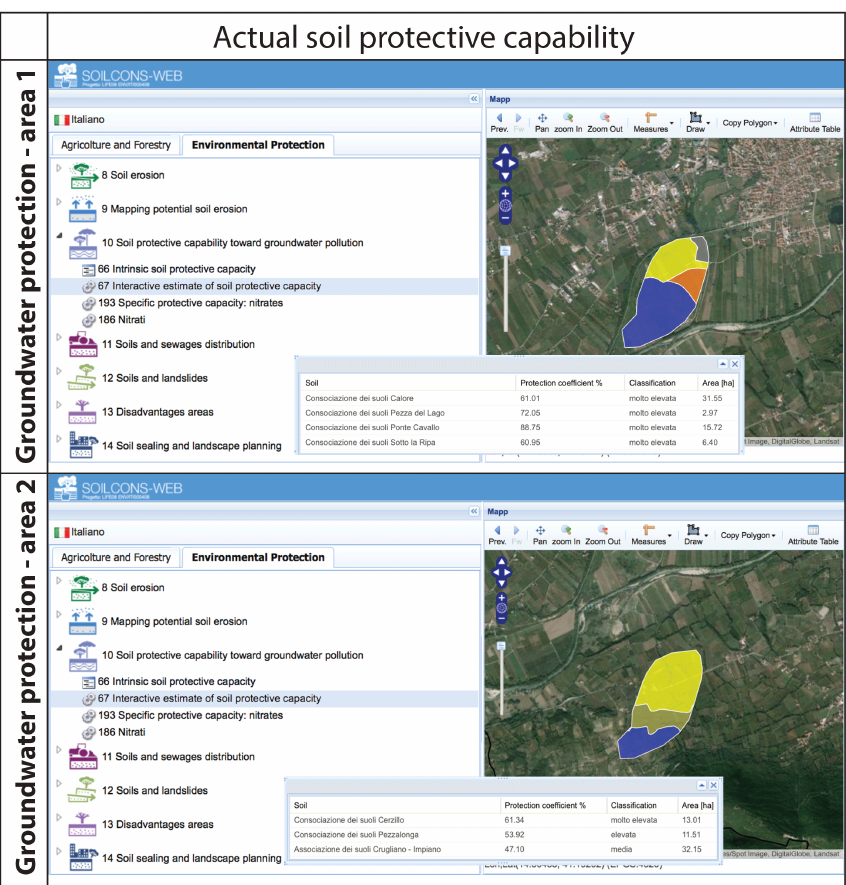
Figure 9. Output examples from the “Soil protective capability towards groundwater pollution” tool: interactive estimate of soil protection